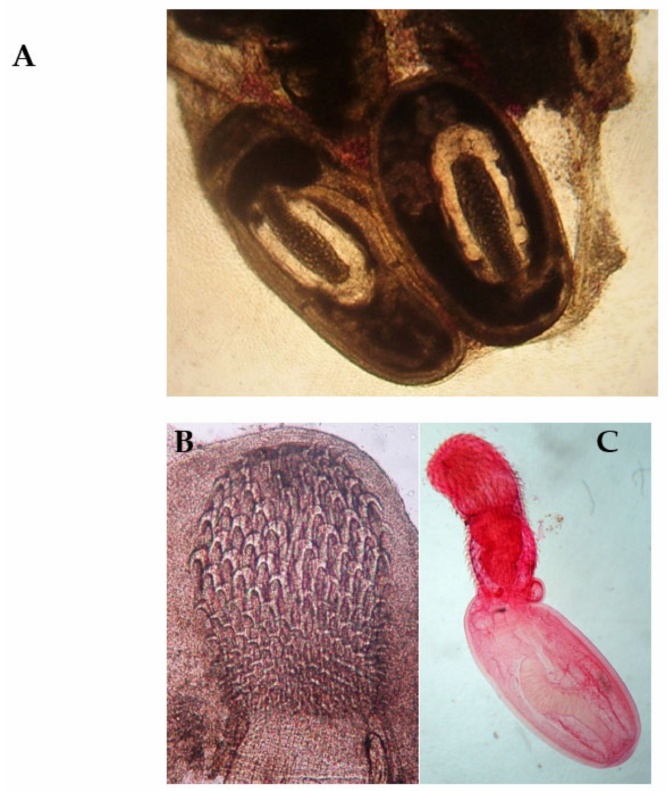
Figure 2. ( A – C ) Some acanthocephalan cystacanths recorded in anuran hosts from